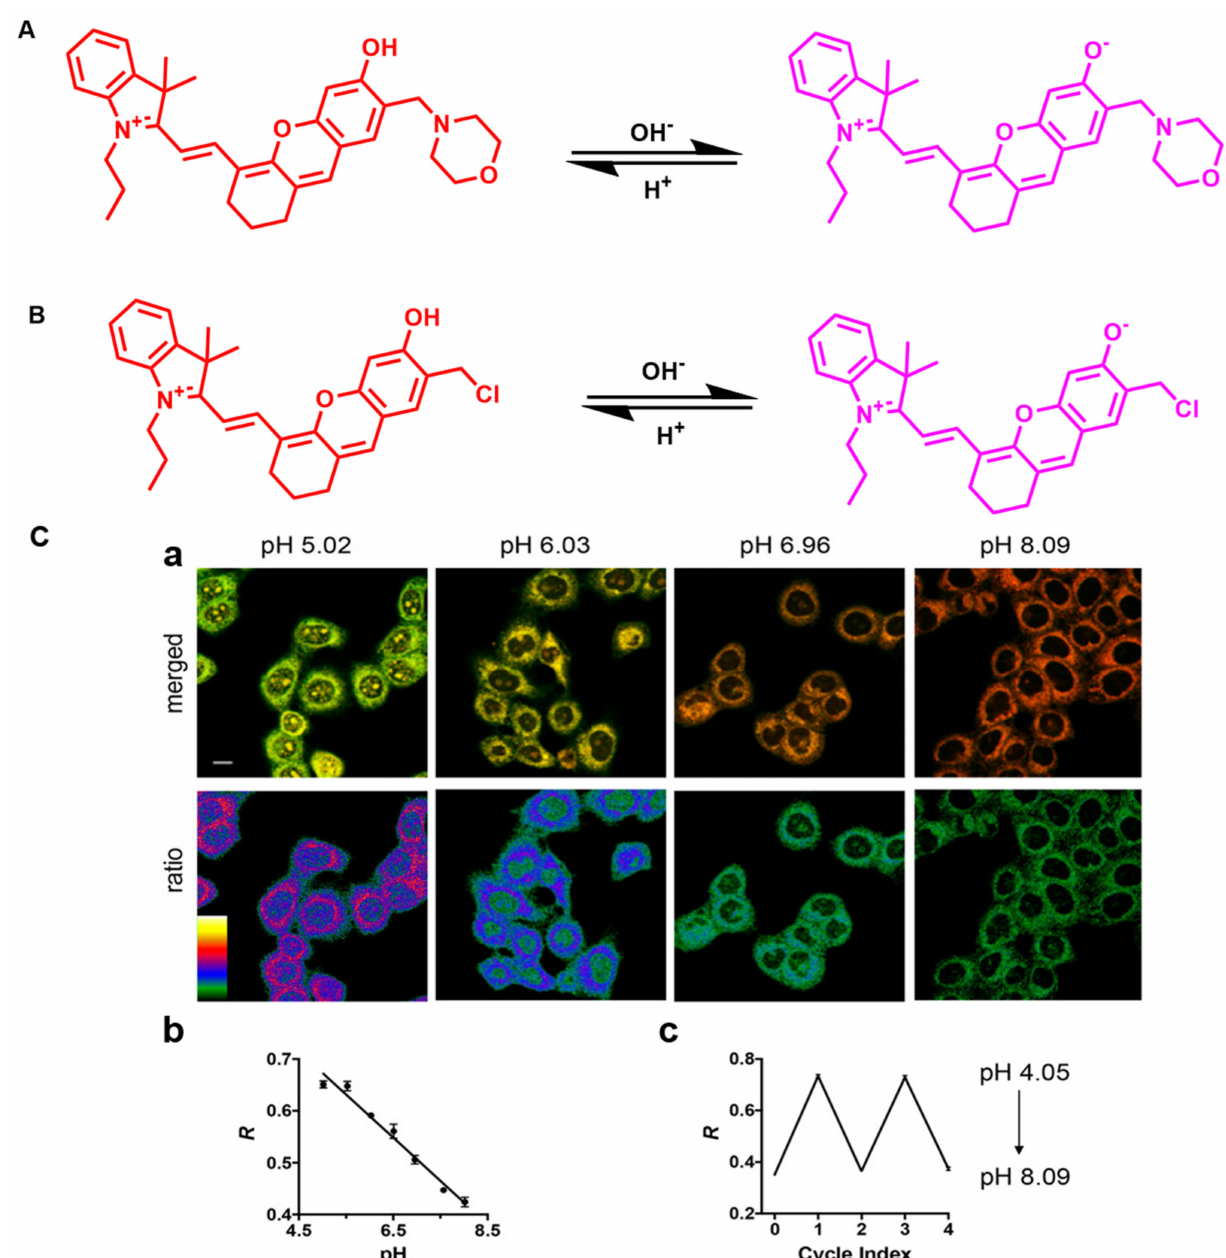
Figure 4. ( A ) Lysosome- and ( B ) mitochondrial-targeted pH fluorescent probes. ( C ) Calibration of intracellular pH in HeLa cells with HXPI-Cl. ( a ) Merged and ratio images of the green and red channels in different pH. ( b ) Linear relationship between the ratio value (R = Igreen/Ired) and pH in HeLa cells. ( c ) Reversibility of HXPI-Cl between pH 4.05 and pH 8.09 in HeLa cells. Reproduced with permission from Ref. [32]. Copyright (2019) American Chemical